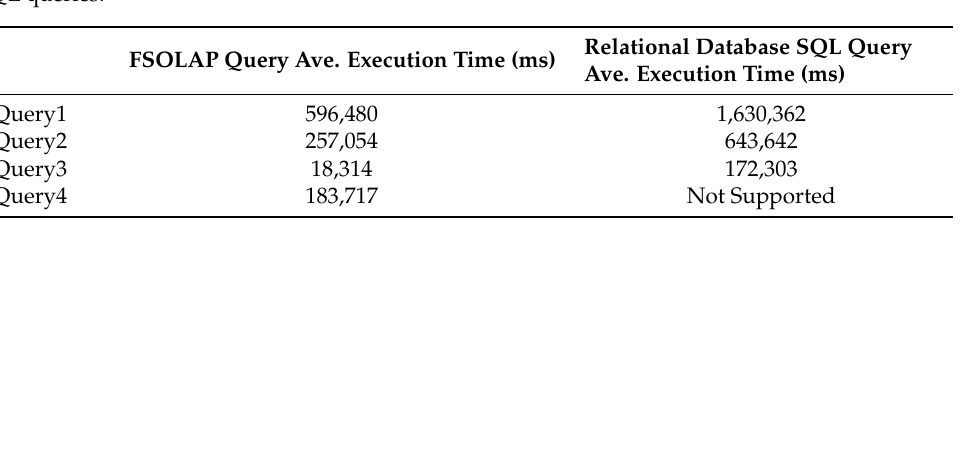
Table 7. Comparison of average execution times between FSOLAP and relational database SQL